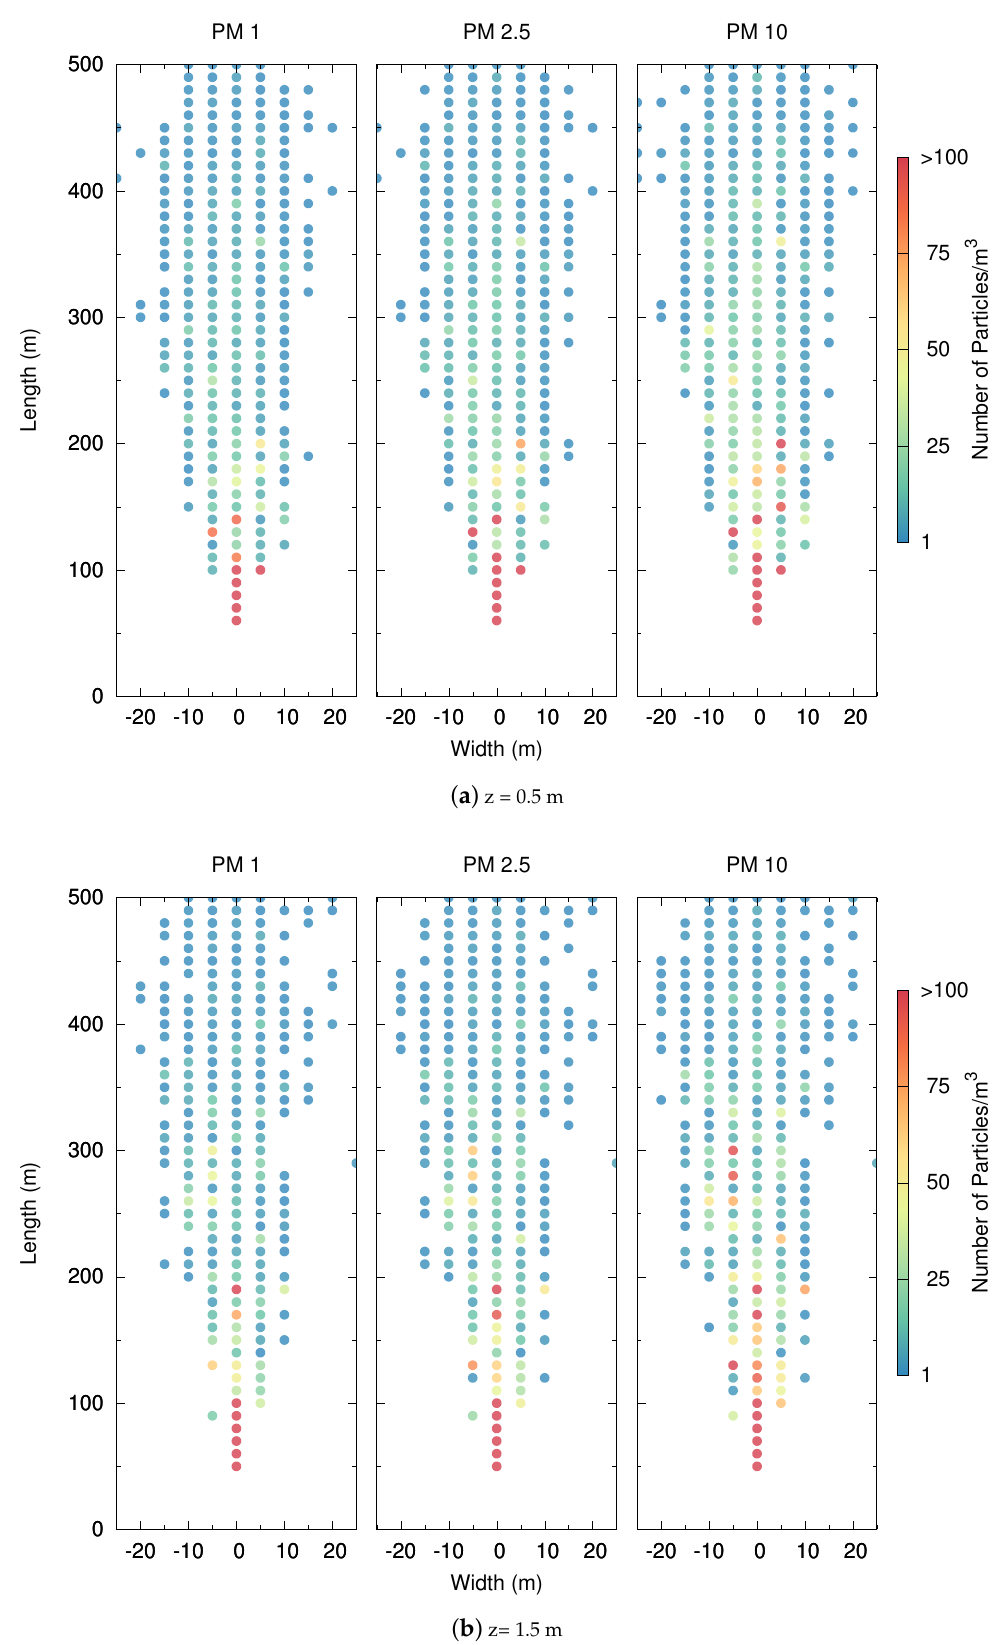
Figure 14. PM1, PM2.5 and PM10 concentration time averaged over 120 s (Density = 316.6 kg/m 3